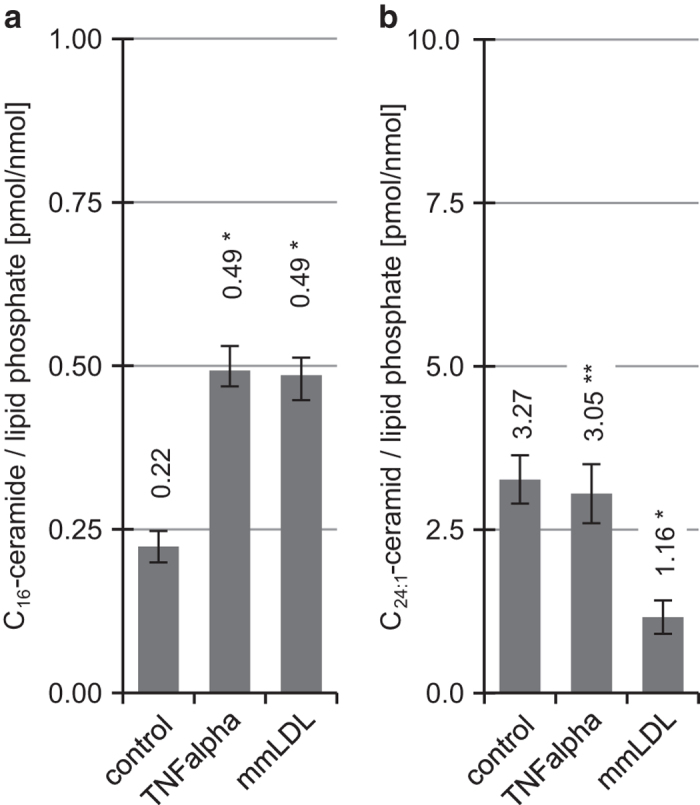
Effect of mmLDL (54 μg ml−1) and TNF-alpha (3 ng ml−1) on ceramide concentration in macrophages. (a) C16-ceramide and (b) C24:1-ceramide concentrations in macrophages after 4 h treatment are shown as mean±S.E., n=3. One-way ANOVA in combination with post hoc t-tests and Bonferroni's correction for multiple testing, P<0.0001 (one-way ANOVA); significant with P<0.05: *versus control, ** mmLDL versus TNF-alpha.